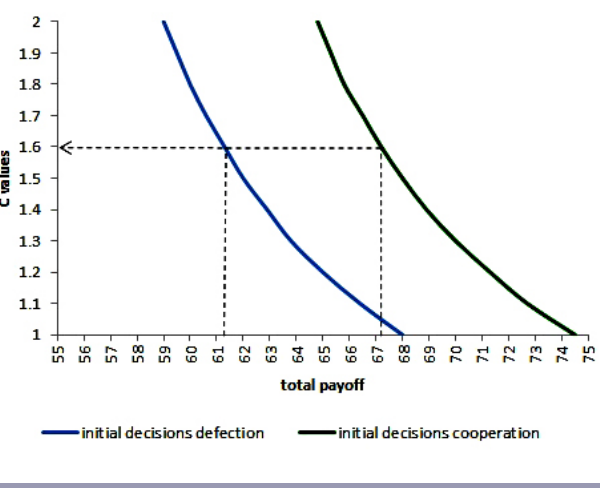
Fig. 9 . C and payoff values in agent-based modeling (ABM) in Kenya.